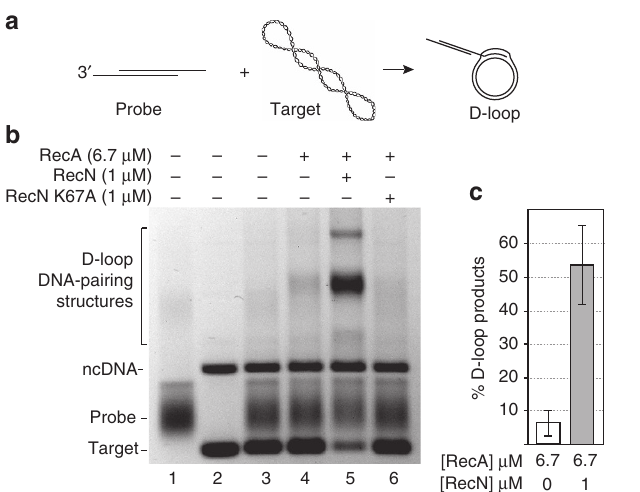
Figure 2 | RecN stimulates RecA-dependent D-loop formation. ( a ) Schematic of RecA-dependent D-loop reaction. RecA filaments formed on the linear duplex plasmid DNA substrate containing 150-nucleotide (nt) 3 0 -ssDNA overhangs (probe) promote strand invasion within the 2.4kb, homologous, supercoiled plasmid DNA (target). RecA exchanges the